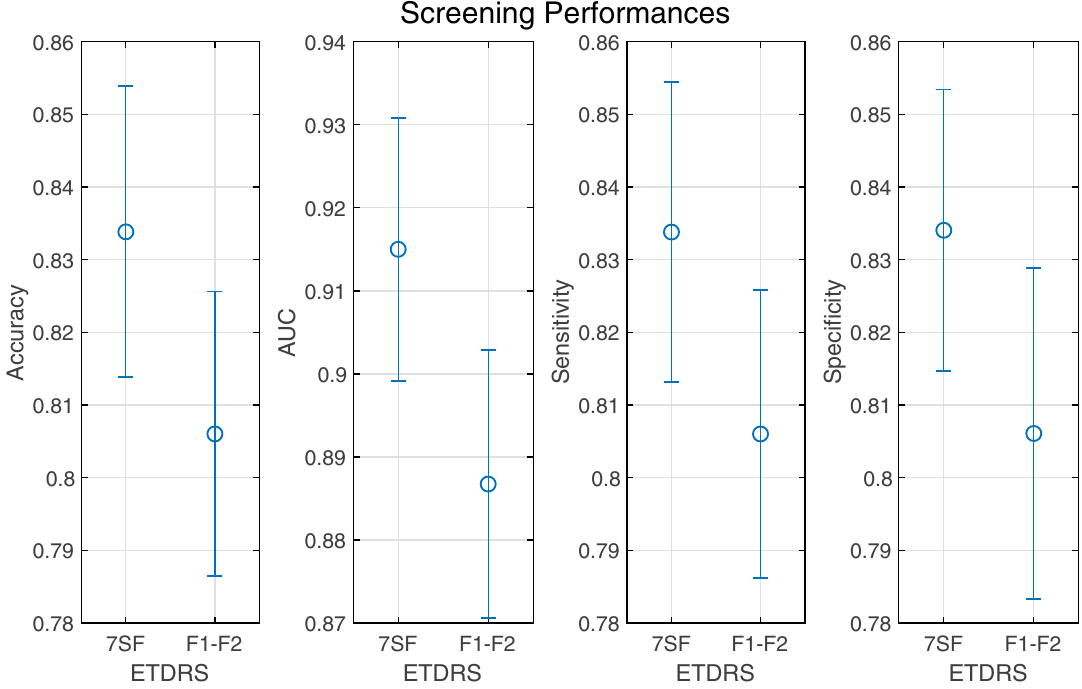
Figure 7. The DR detection performances of the system using ETDRS 7SF and F1–F2 fundus images in terms of accuracy, AUC, sensitivity, and specificity. For each metric, plots show the mean (marked with blue circle) and deviations (marked with blue bar).